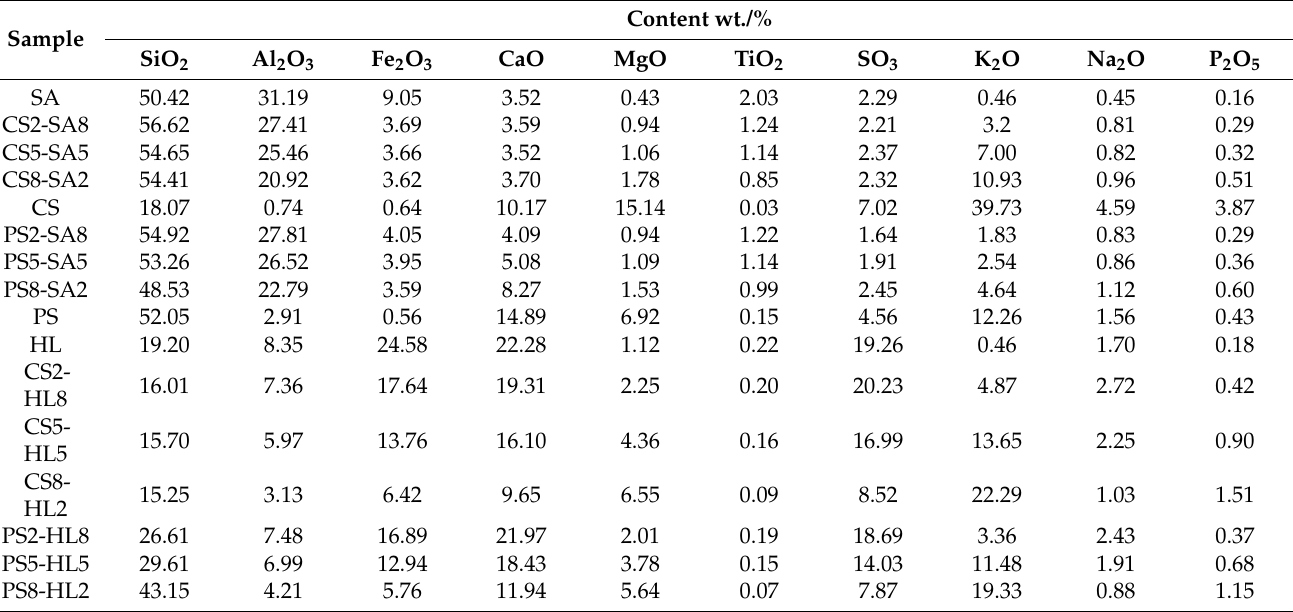
Table 3. The content of element in different char